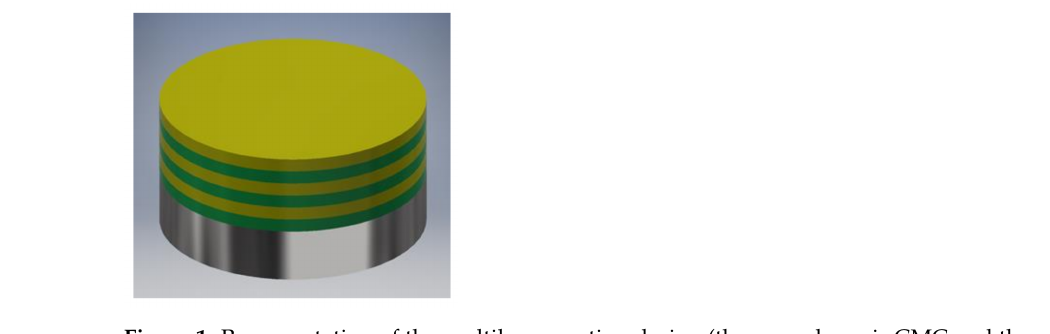
Figure 1. Representation of the multilayer coating design (the green layer is CMC and the yellow layer is DEX solubilised with β